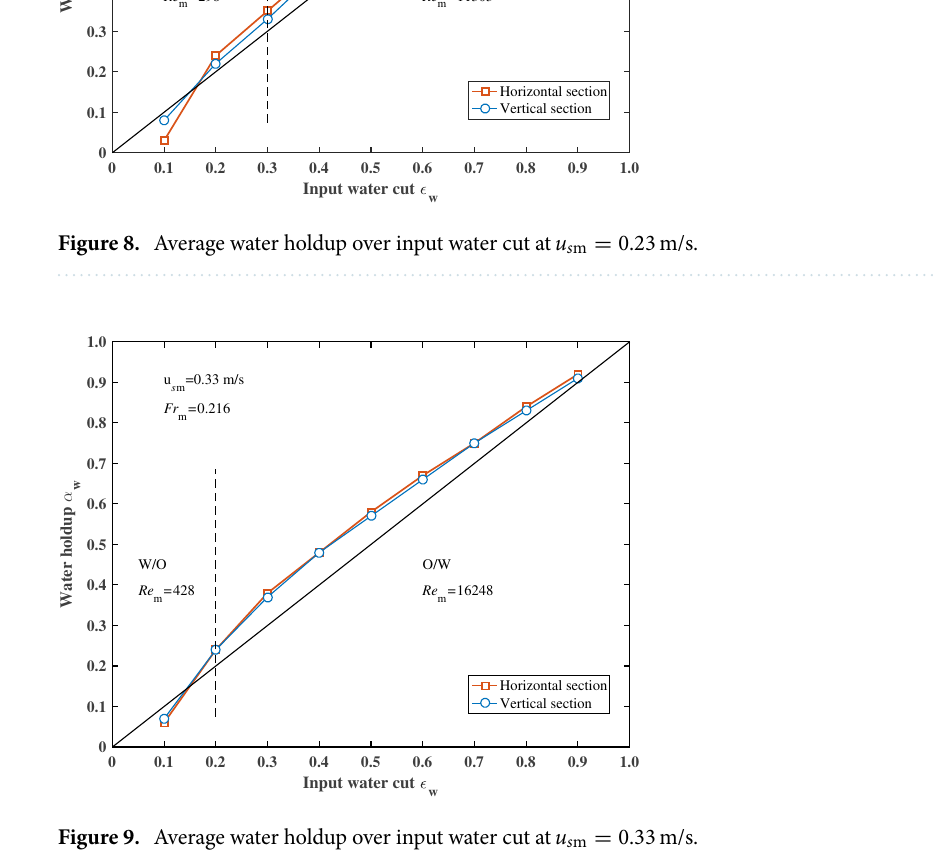
Figure 9. Average water holdup over input water cut at u s m = 0.33 m/s.